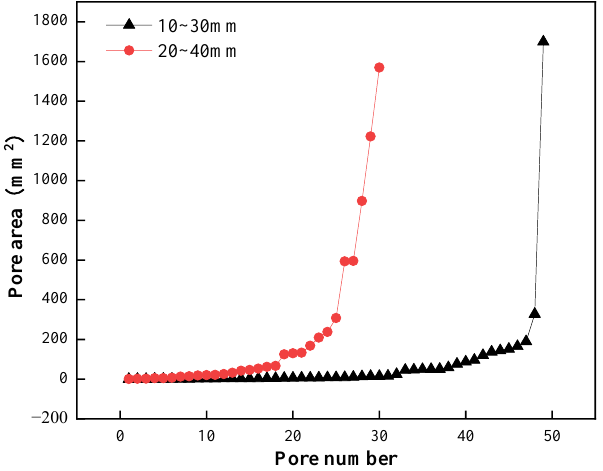
Figure 6. Pore area distribution of planting concrete planes. The average diameter distribution of the pore space in the plane of the planting concrete is shown in Figure 7. The average diameter reflects the general level of pore size of the specimen. As shown in Figure 7, planting concrete prepared with an aggregate particle diameter of 10–30 mm has 64% tiny pores with an average diameter below 5 mm and only 2% larger pores over 20 mm. This shows that the internal structure of the planting concrete prepared with 10–30 mm aggregates is denser and stronger. Planting concrete prepared from 20–40 mm aggregates has a more even distribution of average pore diameter, with only 34% tiny pores with an average pore diameter of less than 5 mm and 16% larger pores over 20 mm. This shows that the internal pores of the planting concrete prepared with 20–40 mm aggregate are mostly larger pores, which are conducive to the development of plant root systems.